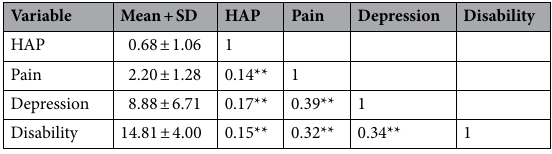
Table 2. Bivariate correlations (N = 5471). *p < 0.05, **p <